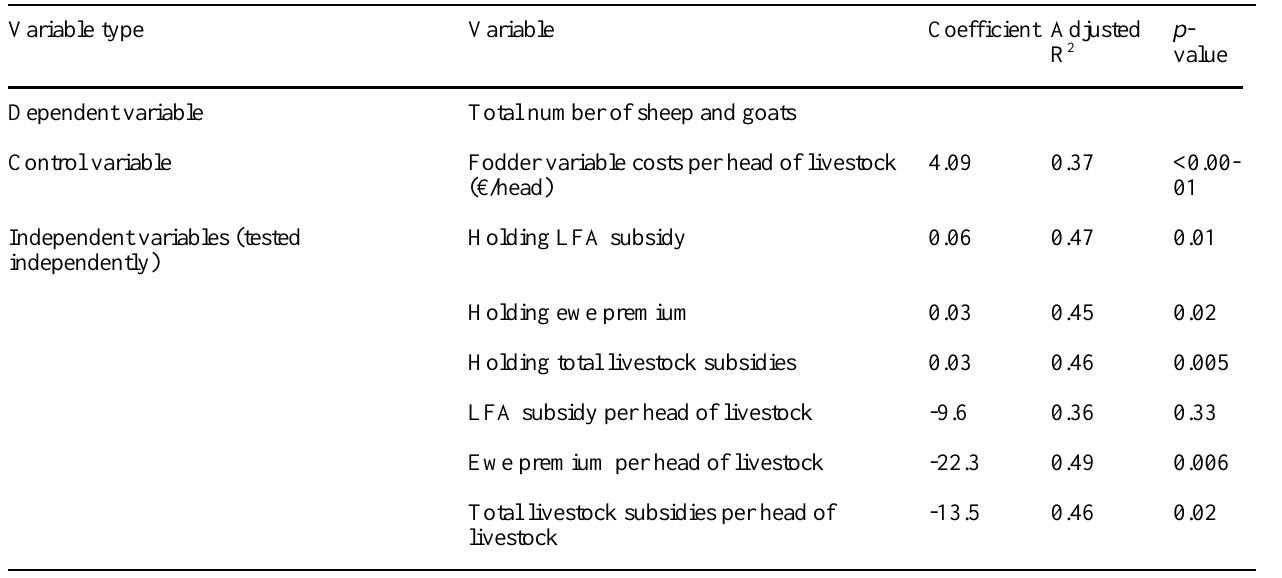
Table 5. Linear regression results for livestock subsidies level and intensity as explanatory variables for flock-size increase ( n =